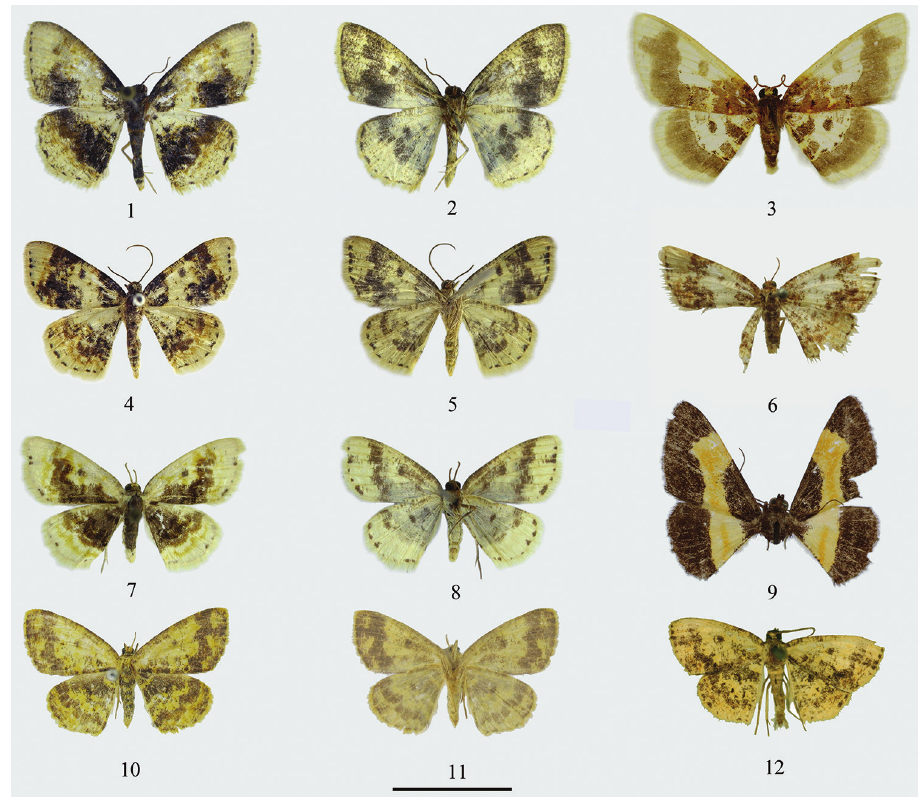
watanabei , male (holotype, coll. NHM) 4–5 N. albarius 4 male 5 ditto, underside 6 N. miegi , female (ho- lotype, coll. SMTD) 7–8 N. splendens 7 male collected from Shanghai, May 8 ditto, underside 9 N. fla- vimedia , female (holotype, coll. NHM) 10–12 N. splendens (“ scintillans ”) 10 male, collected from Gansu in July 11 ditto, underside 12 male, collected from shanghai (syntype of N. scintillans , coll. MNHN). Scale bar 1